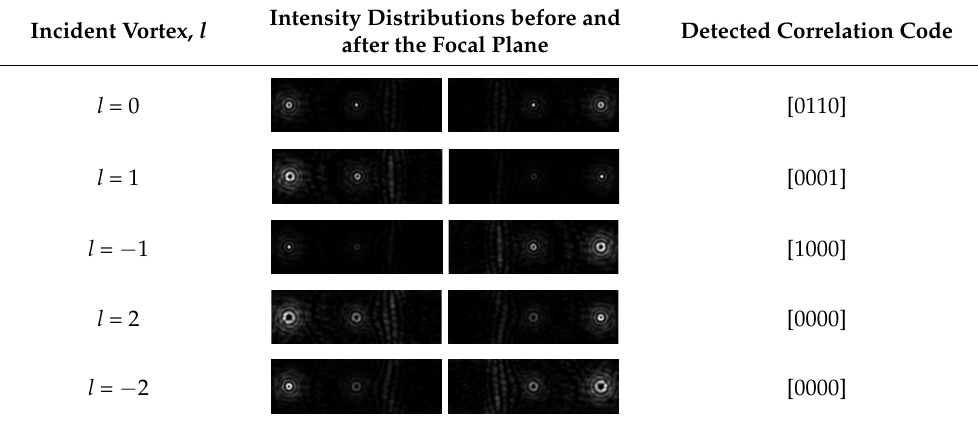
Table 1. Results of detection of vortex phase presence (and sign) in the incident radiation with a uniform (circular or linear) polarization state. Incident Intensity Distributions before and Vortex, l Intensity Distributions before and after the Focal Incident Vortex, l after the Focal Plane